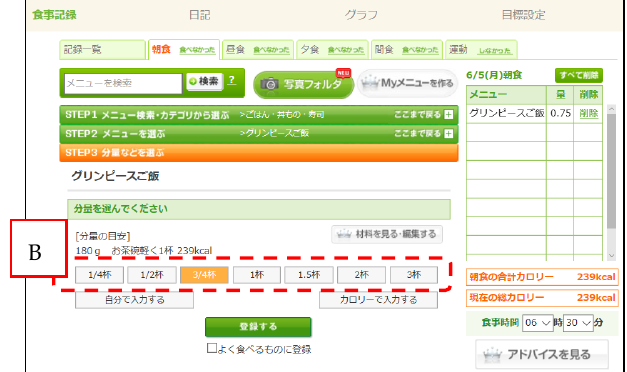
Figure 2. Choosing the serving size for a dish using the Japanese version of Asken. After selecting the specific dish, users select the appropriate serving size for the dish they consumed. Translation of serving sizes in area B (left to right): 1/4 of the serving, 1/2 of the serving, 3/4 of the serving, 1 serving, 1.5 servings, 2 servings, and 3 servings.